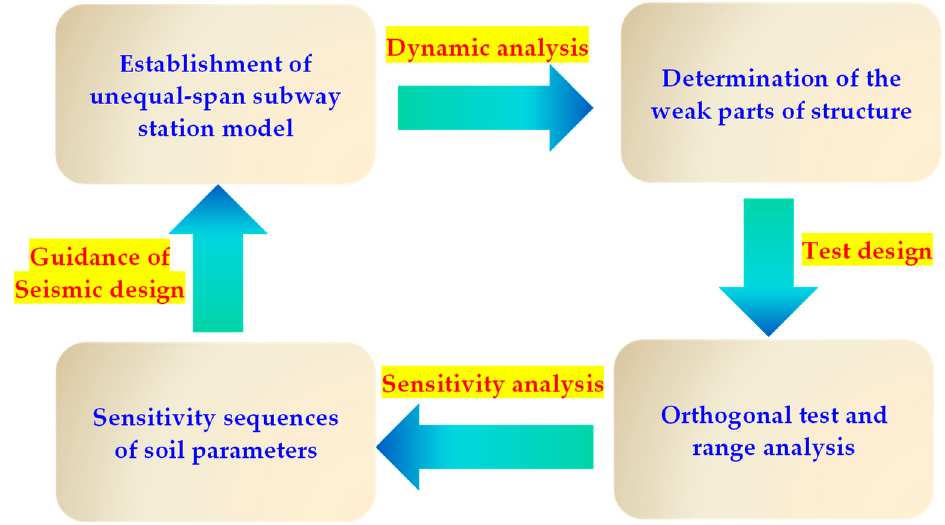
Figure 1. Flow chart of the main steps.